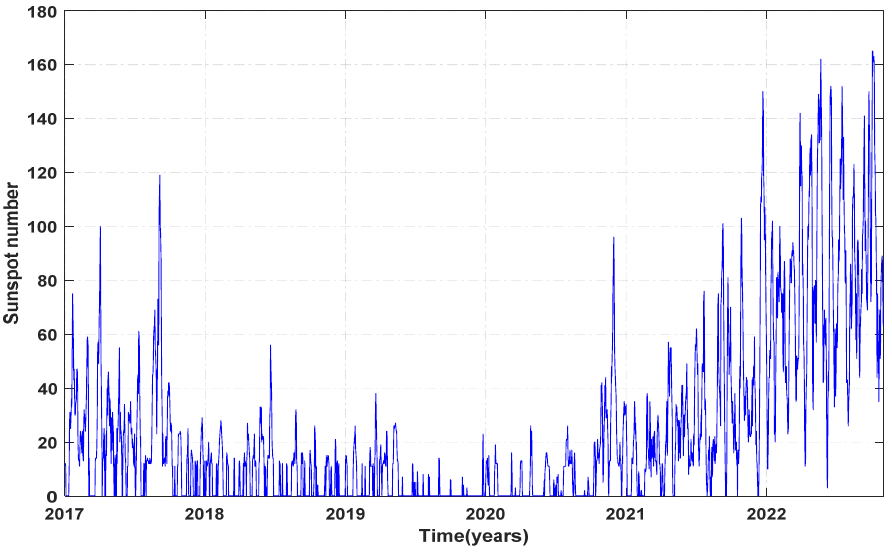
Figure 1. Sunspot number changes from 2017 to present.